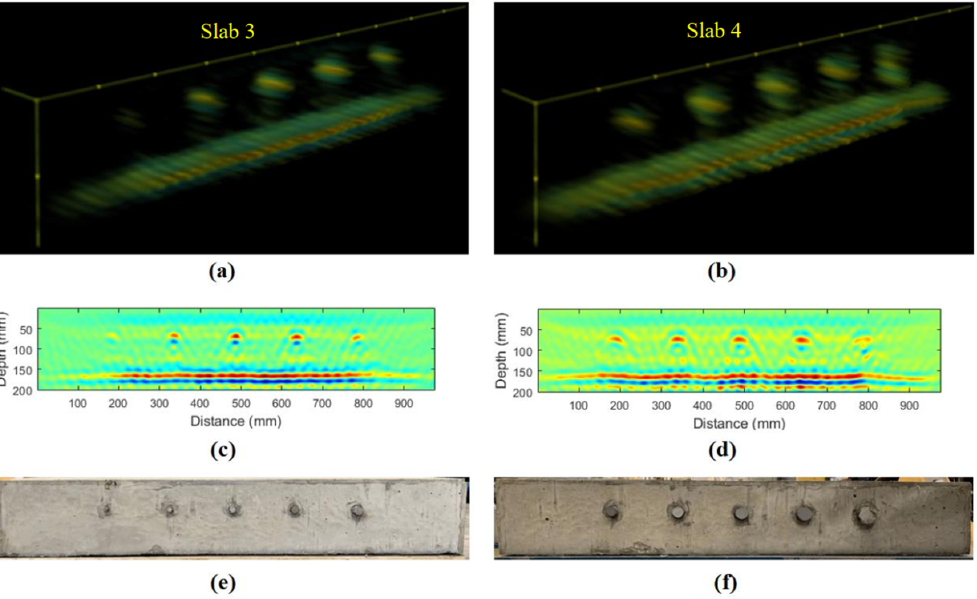
Figure 8. Imaging results for slab 3 and slab 4: ( a , b ) 3D images, ( c , d ) B-scan images, ( e , f ) side-view photos.